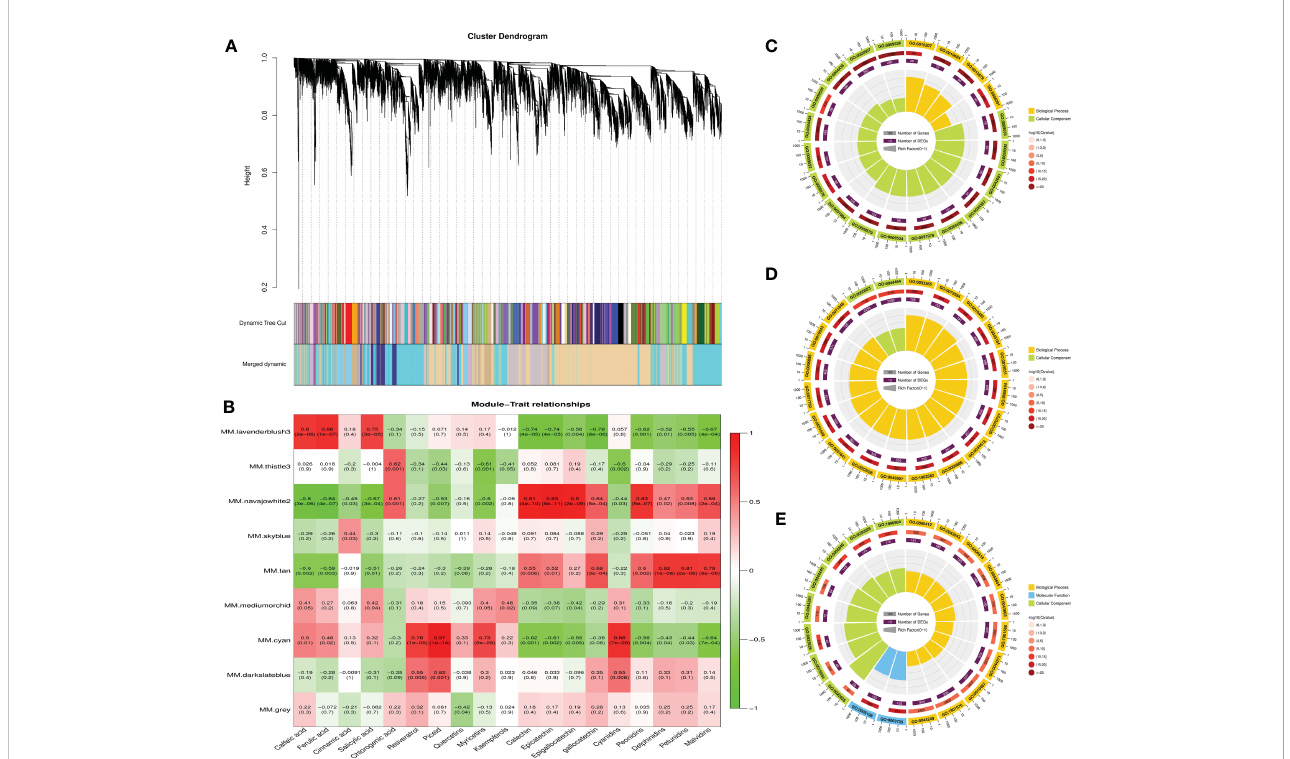
FIGURE 8 Weighted gene co-expression network analysis (WGCNA) of DEGs among different grape varieties and GO enrichment analyses of DEGs associated with the accumulation of phenolic compounds. (A) Cluster dendrogram showing co-expression modules identi fi ed by WGCNA. The major tree branches constitute 9 modules labeled by different colors. (B) Module – trait relationships. Each row corresponds to a module. Each column corresponds to a group of phenolic compounds. The color and data of each cell indicates the correlation coef fi cient between the module and the phenolic compound. A high degree of correlation between a speci fi c module and the phenolic compound is indicated by red (positive) or green (negative). Red to green represents a positive to negative correlation between them. (C) GO enrichment analysis of DEGs in the lavenderblush module. (D) GO enrichment analysis of DEGs in the navajowhite module. (E) GO enrichment analysis of DEGs in the cyan